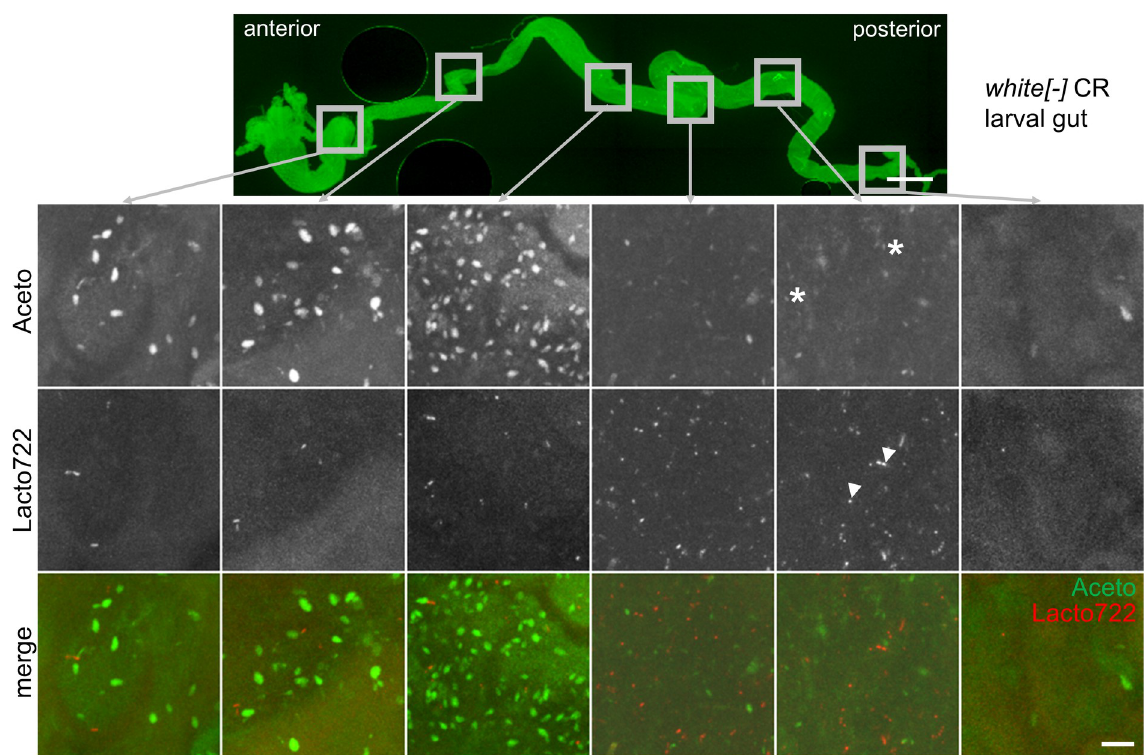
Fig 4. Fluorescence in situ hybridization of larval Drosophila guts. FISH was performed with Carnoy’s solution-fixed larval Drosophila guts using the genera-specific probes Aceto (green) and Lacto722 (red) (4 μ M/probe) and 40% formamide for 16 hours at 46˚C. Prior to hybridization, larval guts were treated with 10 mg/ml lysozyme for 15 minutes at 37˚C. An overview of the entire gut was imaged and detailed zoom-ins of 6 different regions are shown. The figure shows representative examples from at least three separate experiments. Exemplary Acetobacter cells are marked with asterisks and Lactobacillus cells are indicated by arrowheads. In each experiment 5 to 10 guts per condition were dissected. Scalebars represent 500 μ m (overview) and 10 μ m (zoom-ins).